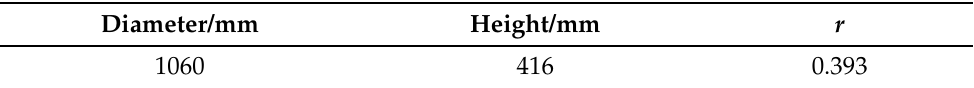
Table 2. AUH’s basic dimensions used for following simulation cases.